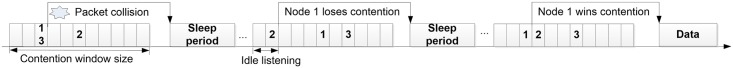
Three possible contention results.